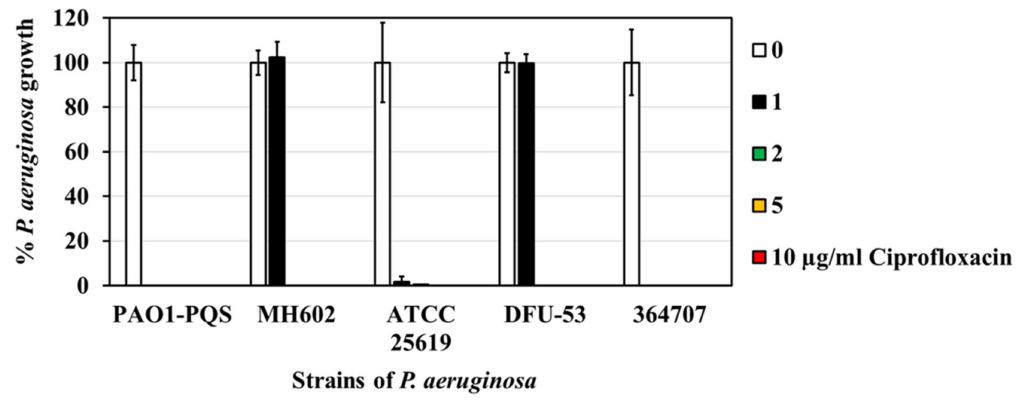
Figure 1. The susceptibility of P. aeruginosa isolates to ciprofloxacin.